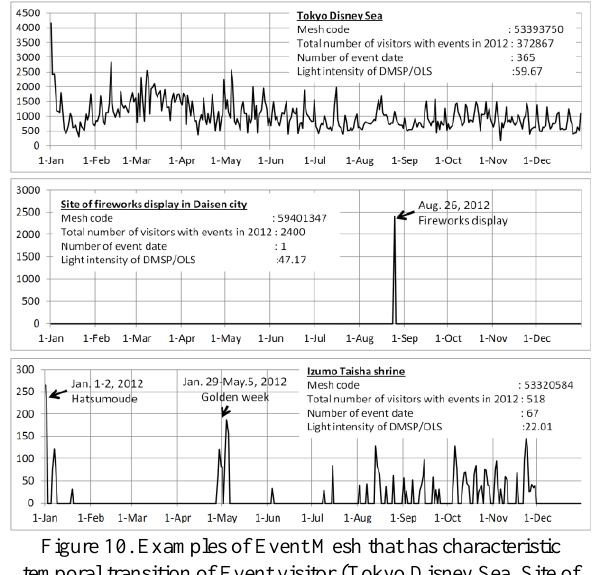
Figure 10. Examples of Event Mesh that has characteristic temporal transition of Event visitor (Tokyo Disney Sea, Site of fireworks display in Daisen city and Izumo Taisha shrine)